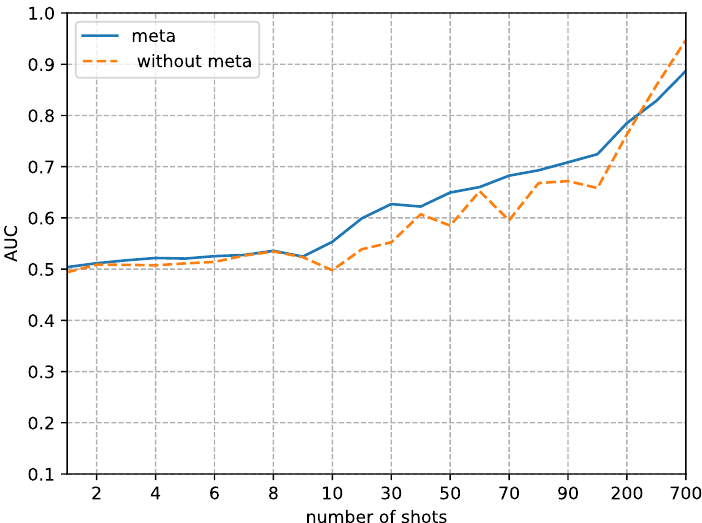
Figure 10. Comparison of AUC between random initial weights (without the proposed method) and meta-learning of detecting images altered by FaceSwap manipulation methods. The x-axis is the size of the fine-tuned training set and the y-axis is the value of